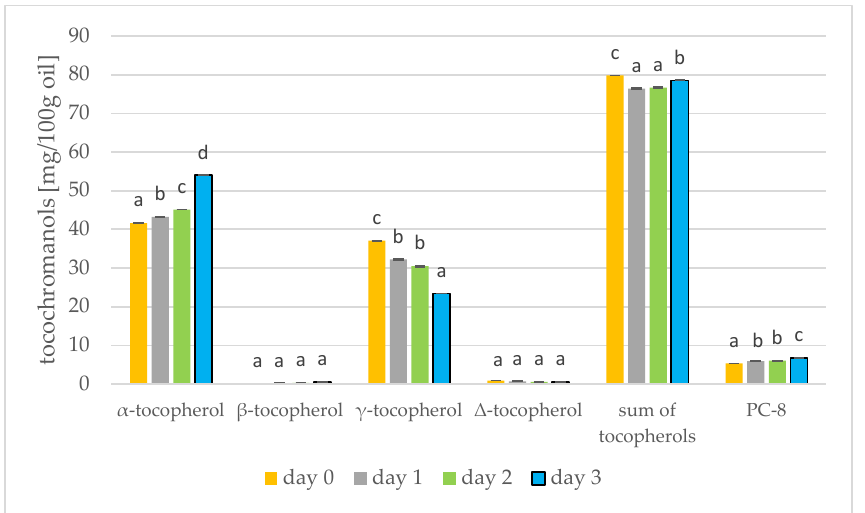
Figure 6. Levels of tocochromanols [mg/100 g oil] during rapeseed germination (days 0, 1, 2, 3) PC ‐ 8—plastochromanol ‐ 8 (values are means ± SD from three experiments. Values with different letters are significantly different ( p < 0.05)).